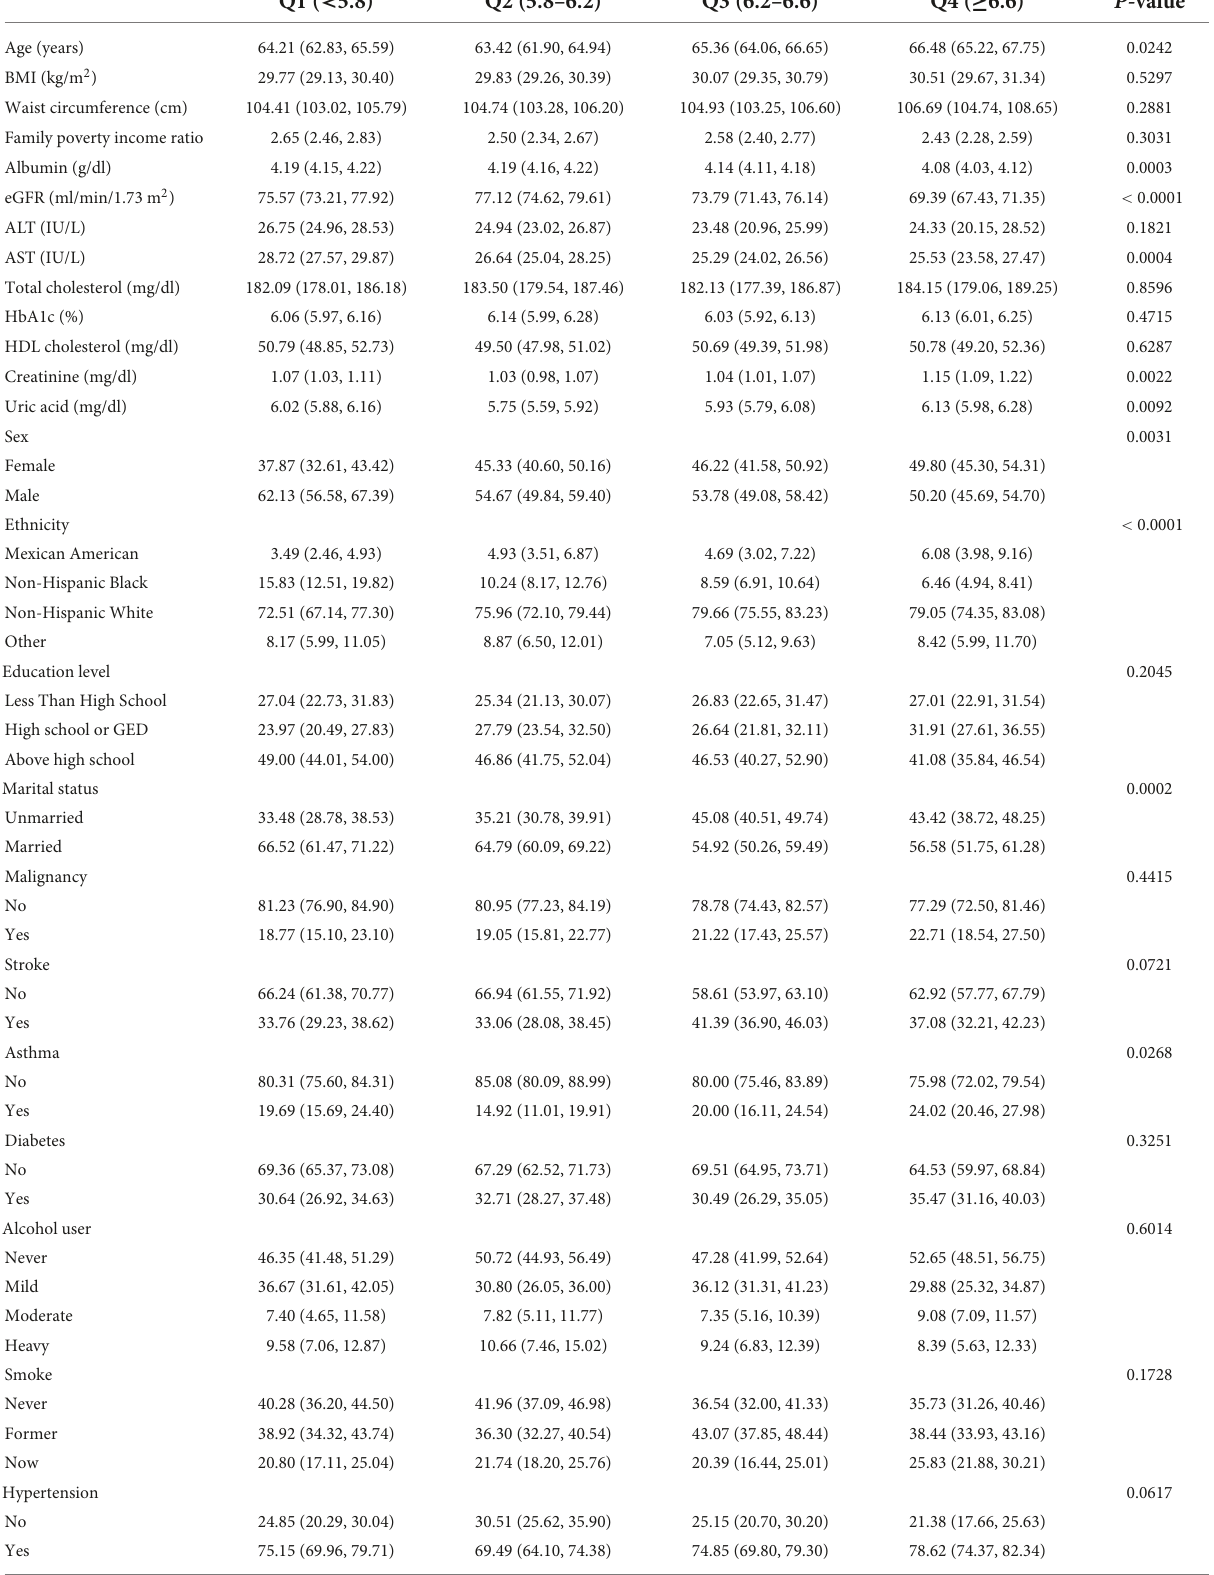
TABLE 1 Baseline characteristics of ASCVD individuals according to ln transform systemic immune-inflammation index quartiles,